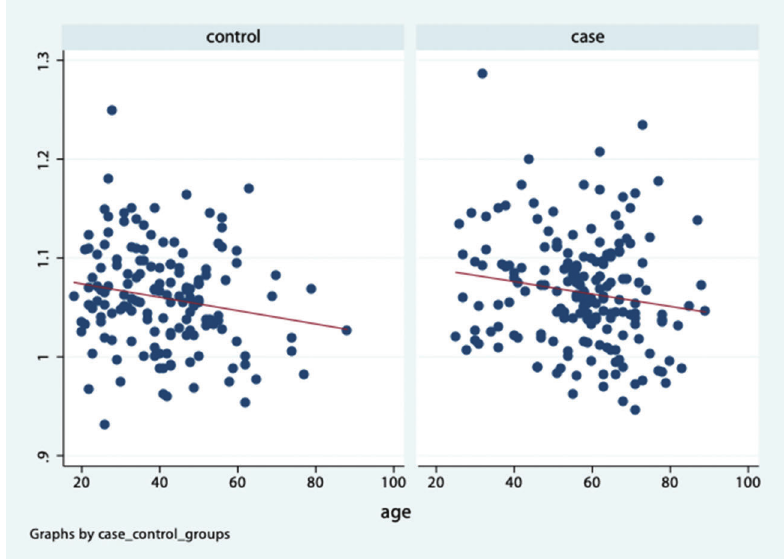
Figure 3 - Dispersion graphic: age versus pelvic–trochanteric index.